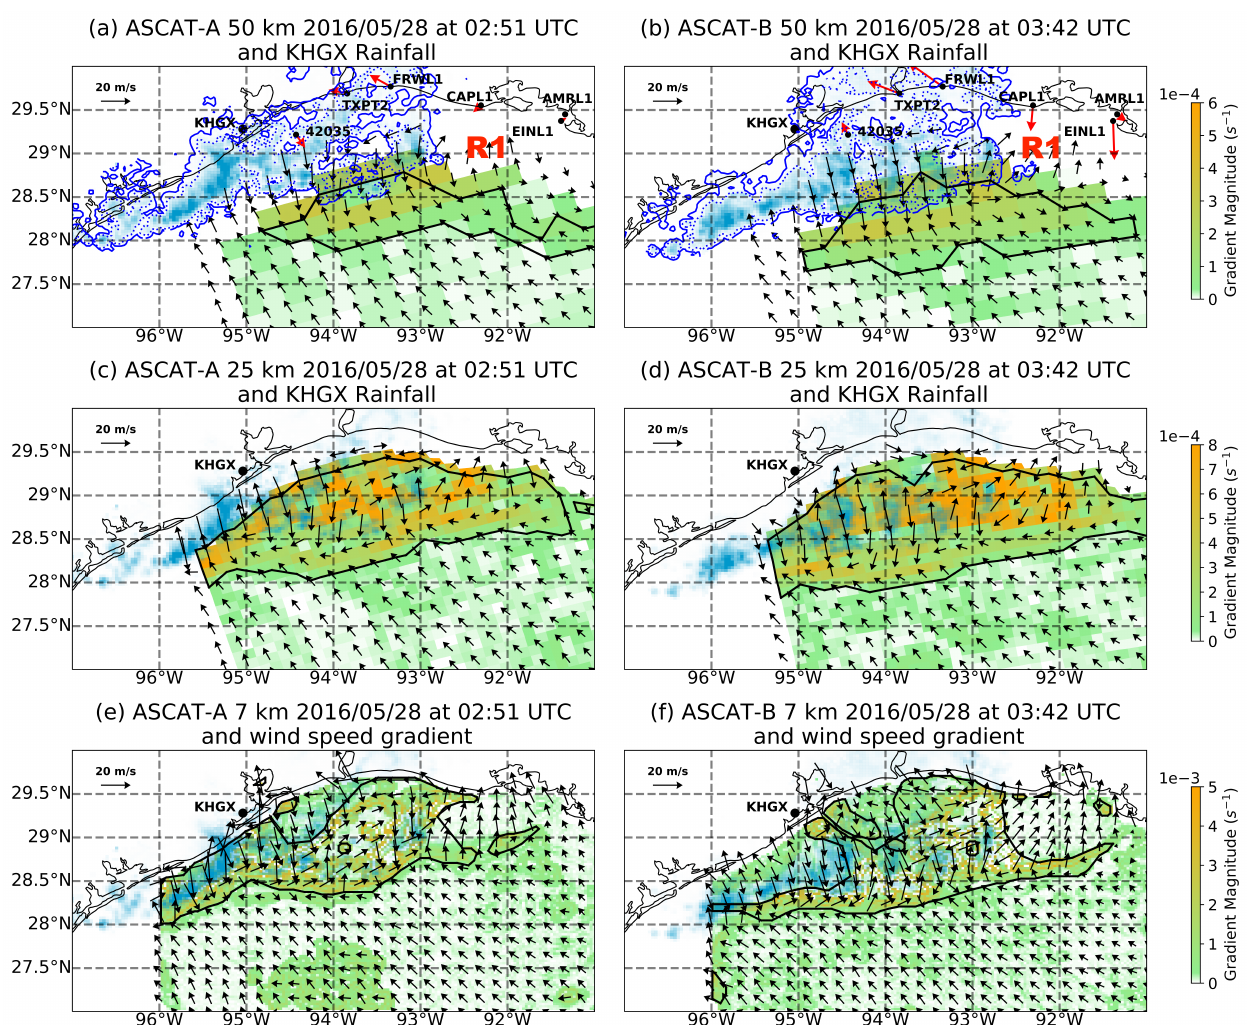
Figure 6. Adjusted ASCAT wind vectors (black vectors) and gradient wind magnitude are depicted for the overpasses of MetOp-A and -B. Left column, i.e., ( a , c , e ), corresponds to ASCAT-A overpass at 02:55 UTC on 28 May 2016; right column, i.e., ( b , d , f ) to ASCAT-B at 03:47 UTC. From top to bottom spatial resolution increases from 50 km to 7 km. Black polygons correspond to gradient wind features. KHGX precipitation rate (>40 mm h − 1 ) is depicted in light blue filled contours and reported at 02:57:26 UTC for ASCAT-A and 03:46:03 UTC for ASCAT-B. In ( a , b ) blue line depicts the 1 mm h − 1 rain rate border along the precipitation region and blue doted line the 6 mm h − 1 . Buoy stations and the corresponding wind (red) vectors are shown in ( a